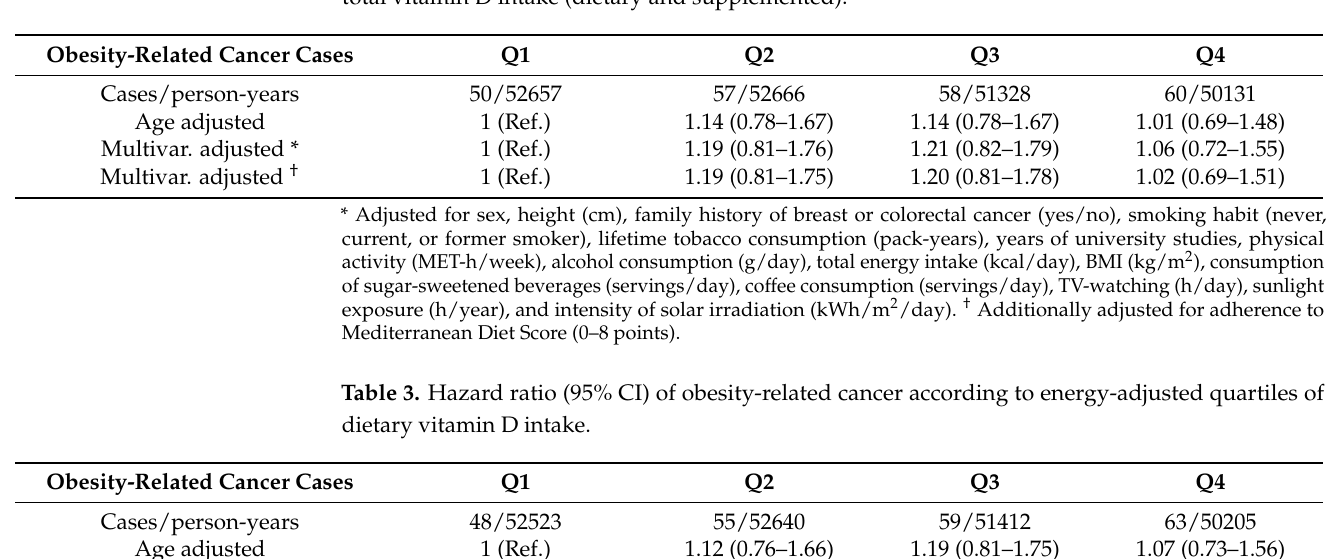
Table 2. Hazard ratio (95% CI) of obesity-related cancer according to energy-adjusted quartiles of total vitamin D intake (dietary and supplemented).